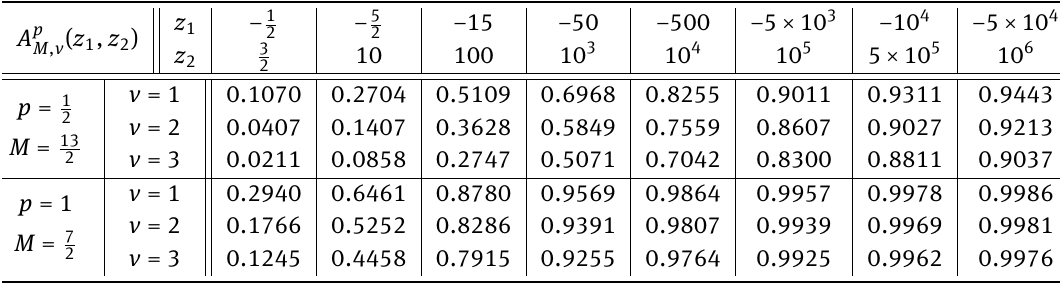
Table 1: Heaviness of the extremely far reaching tails of maximum distribution in jointly l 3, p -symmetrically Pearson Type VII distributed populations with ( p , M ) ∈ (cid:8)(cid:0) 1 2 , 13 2 (cid:1) , (cid:0) 1, 7 2 (cid:1)(cid:9) and ν ∈ { 1, 2, 3 } .